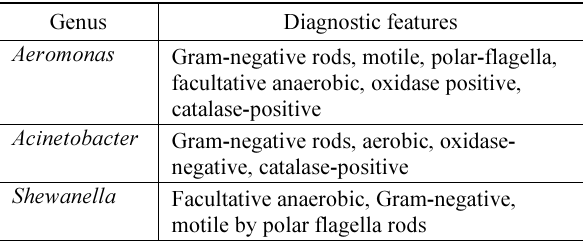
Table 1 . Diagnostic features of hydrocarbon-degrading bacteri-